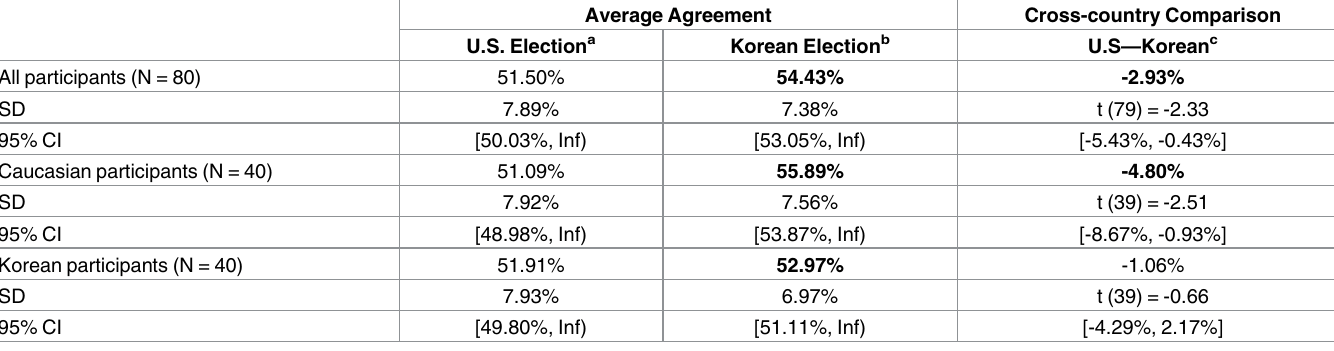
Table 4. Associations between real election outcomes and face-based inferences of threat.